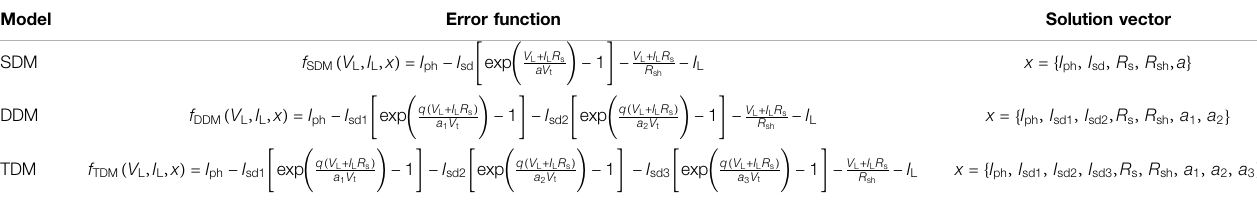
TABLE 1 | Error functions of three different models. Model Error function Solution